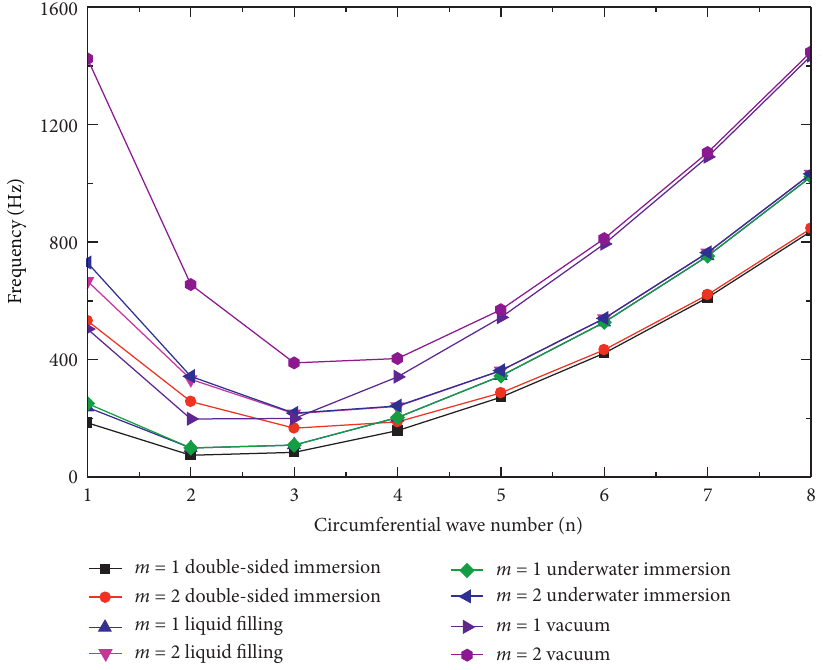
Figure 2: Frequency curves of bare cylindrical shell.